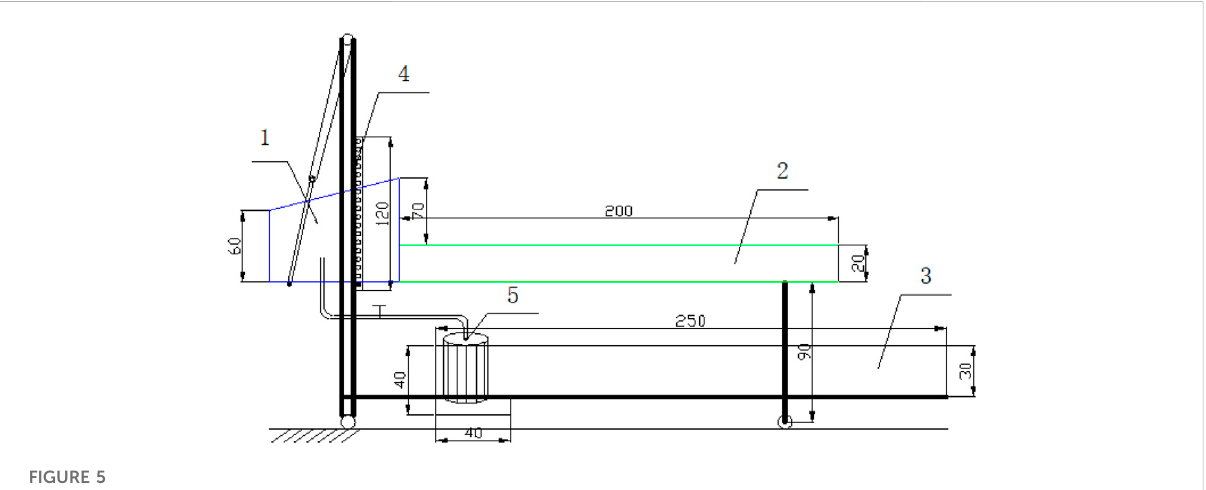
FIGURE 5 Schematic of the experimental setup (units in cm) one water tank, two experiment fl ume, three circular water pond, four frame, fi ve water pump.